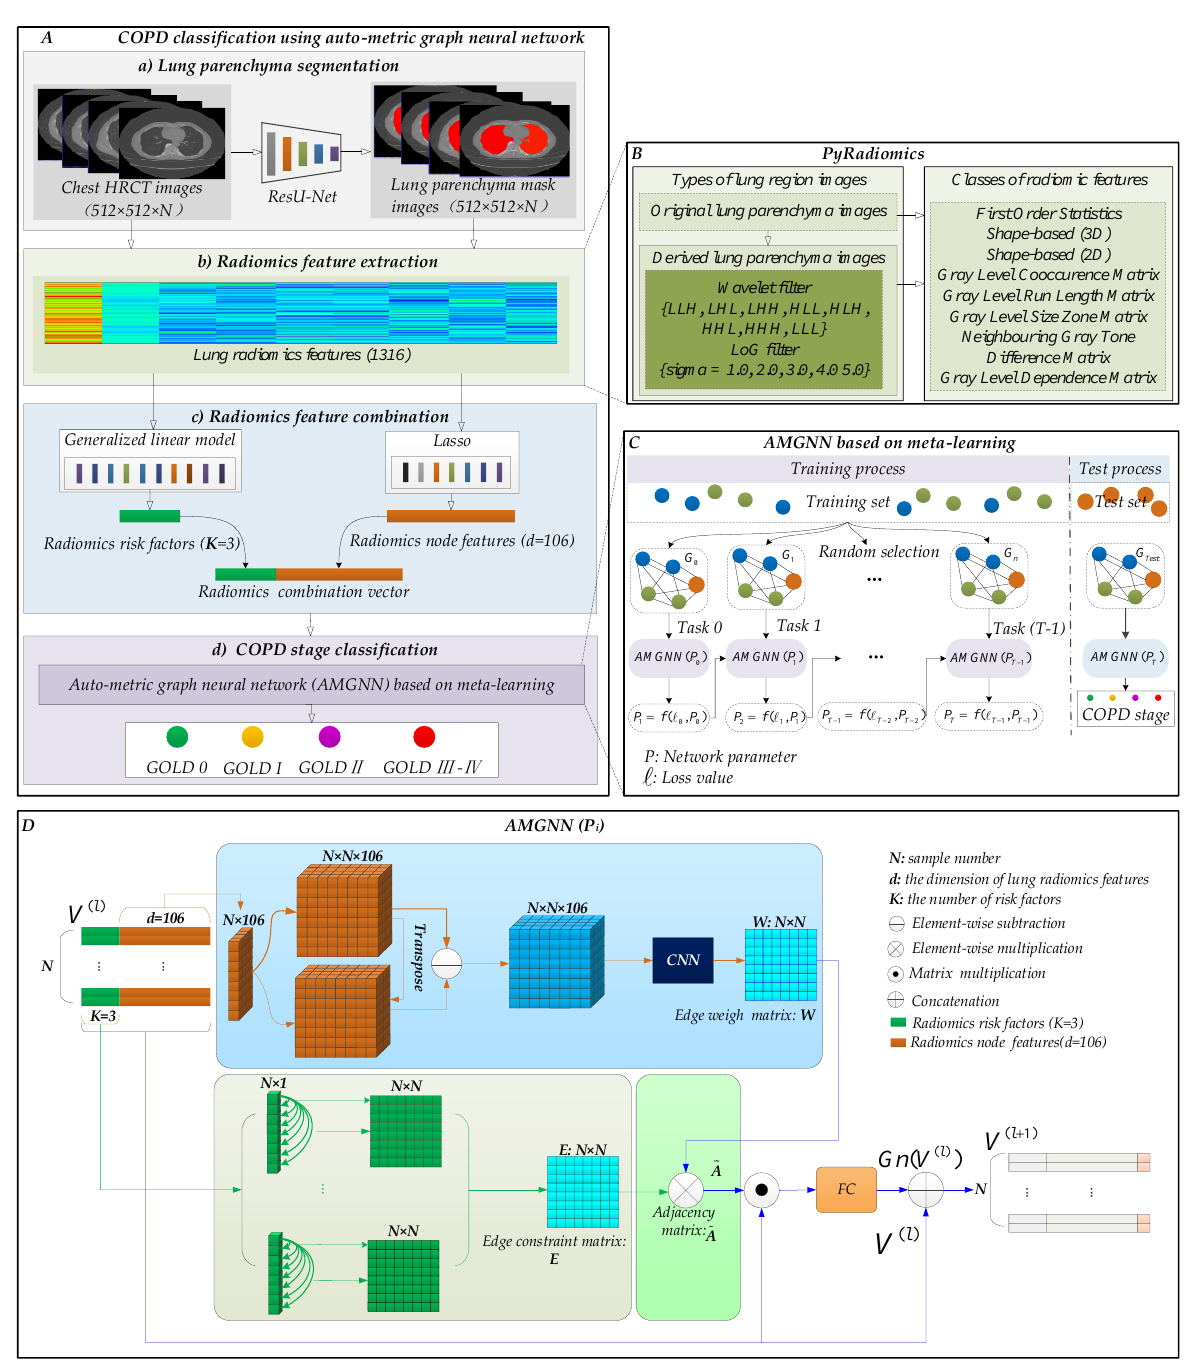
Figure 2. The proposed method in this study. ( A ) Our proposed method: COPD stage classification using auto-metric graph neural network; specifically, our proposed method includes ( a ) lung parenchyma segmentation, ( b ) radiomics feature extraction, ( c ) radiomics feature combination, and ( d ) COPD stage classification. ( B ) Lung radiomics feature extraction model: PyRadiomics [25,29,33,40]. ( C ) The pipeline of the AMGNN based on meta-learning. ( D ) Detailed network structure of the AMGNN ( P i